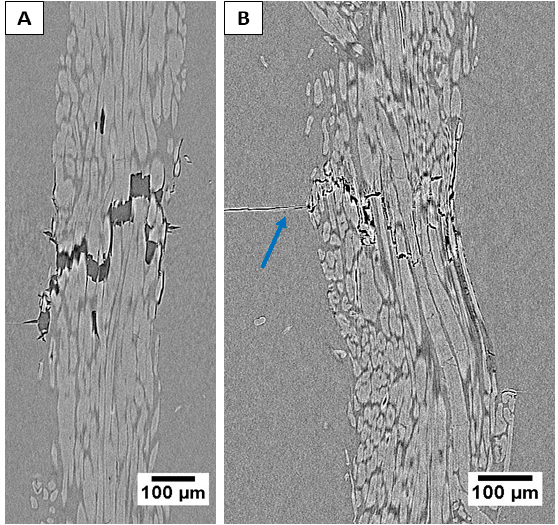
Figure 8. Debonding length observation by micro ‐ computed tomography. High ‐ resolution micro ‐ CT images for supercritical CO 2 treated flax/epoxy ( A ) and flax/vinylester ( B ) single yarn samples. images for supercritical CO 2 treated flax / epoxy ( A ) and flax / vinylester ( B ) single yarn